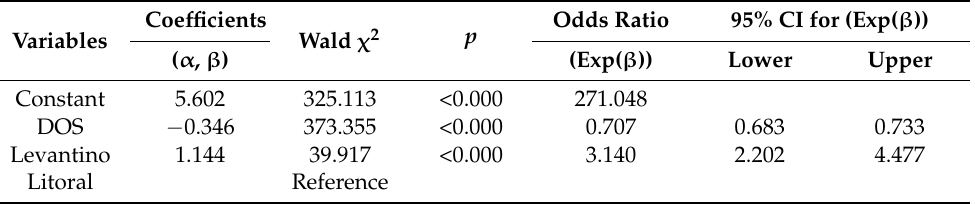
Table 4. Estimation of the multiple logistic regression parameters for cultivars (Levantino and Litoral) and DOS as factors influencing the probability of marketability.